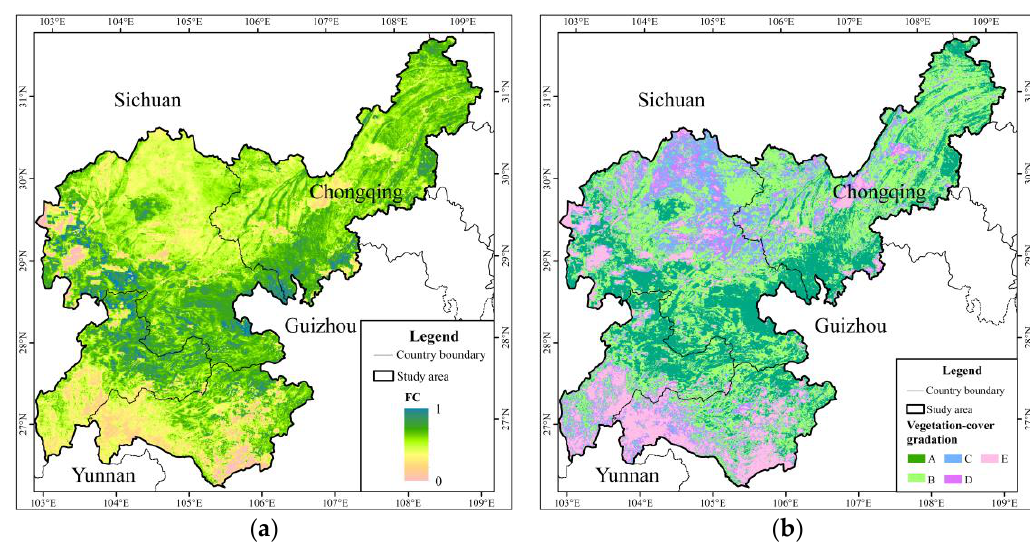
Figure 12. Fractional vegetation cover ( a ); and gradation distribution ( b ) ((A) first class; (B) second class; (C) third class; (D) fourth class; and (E) fifth class).